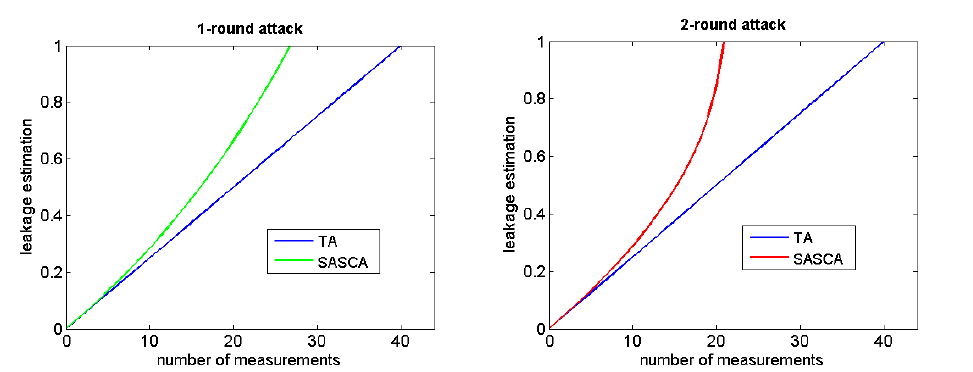
Figure 4: Leakage bounds for the factor graph of Figure